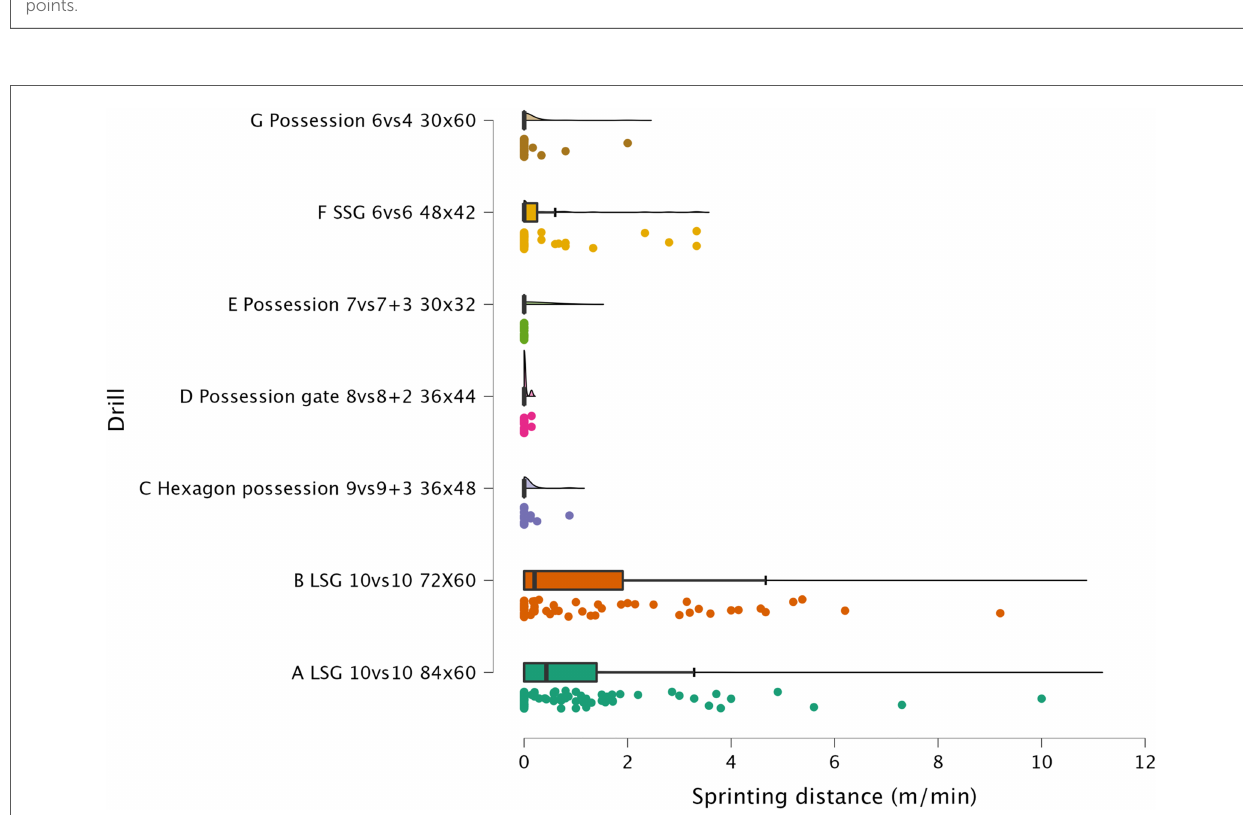
FIGURE 3 Comparison of sprinting distance per minute between drills. The data distributions show, mean, standard deviation, 95% con fi dence intervals, and individual data